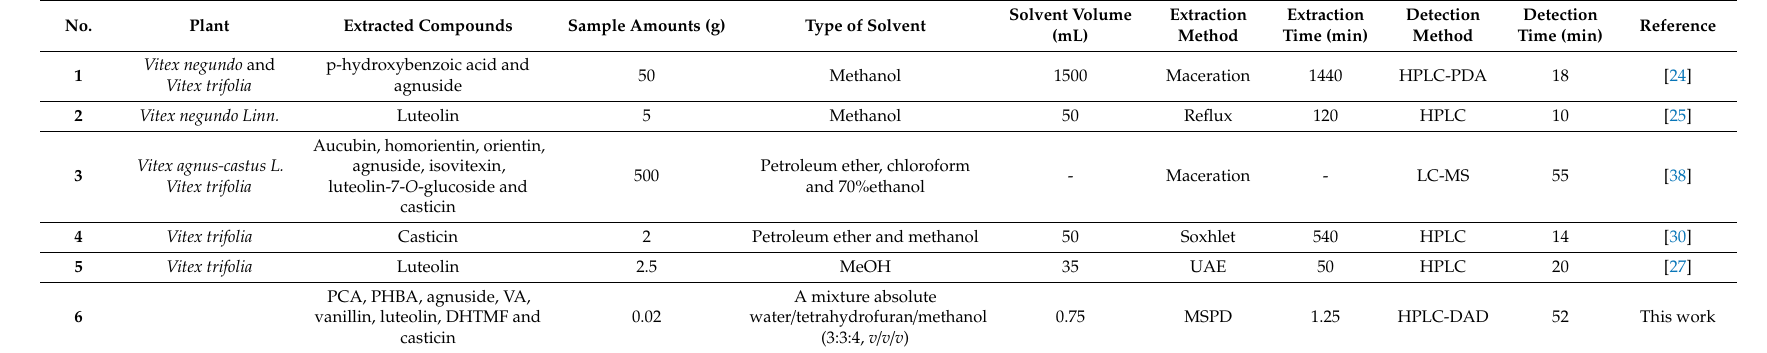
Table 5. Comparison of the MSPD method with other methods in the determination of compounds in Fructus Viticis